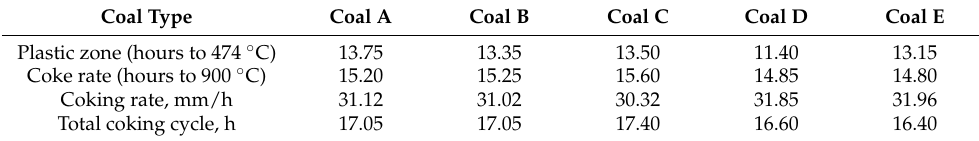
Table 3. Pilot oven conditions.